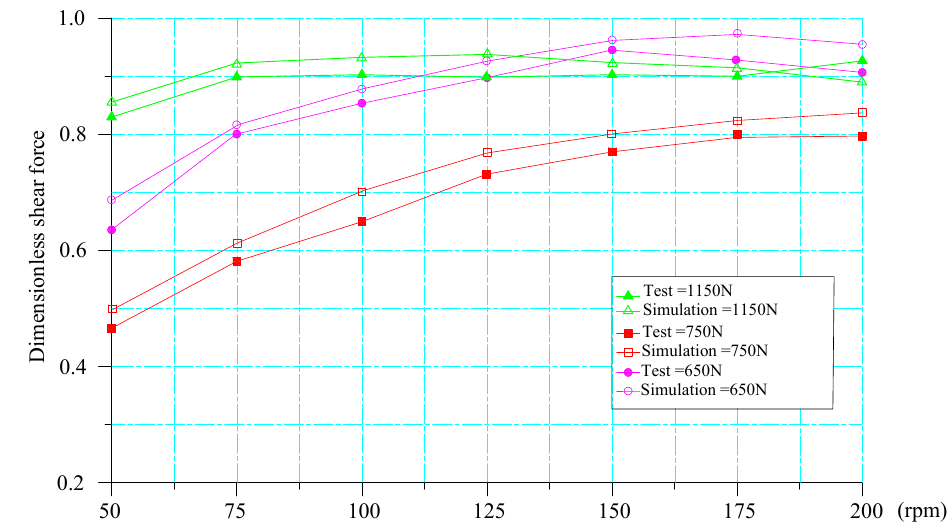
Figure 22. Comparison between dimensionless shear force and simulation results in different work- ing